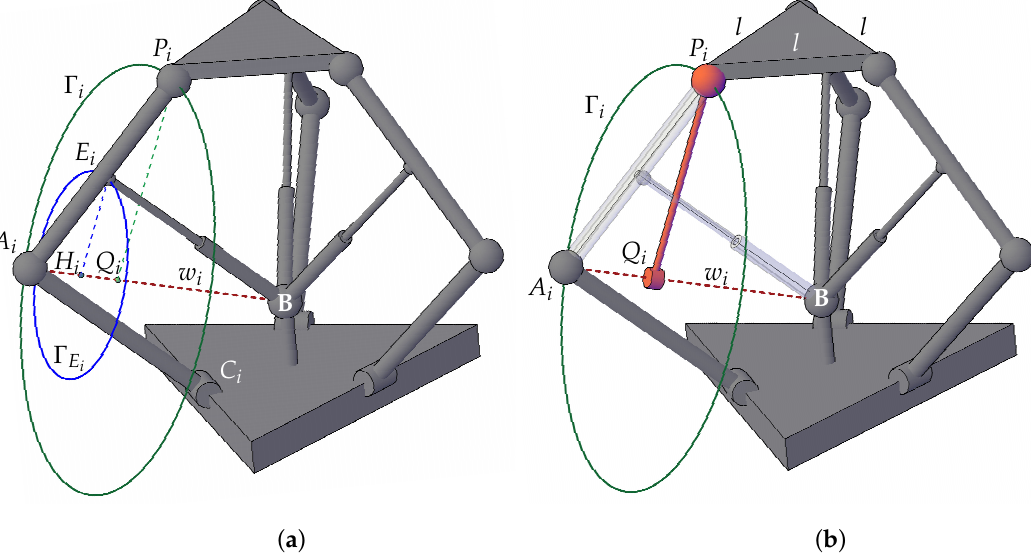
Figure 3. ( a ) The circles Γ E and Γ i as loci of points E i and P i , respectively, for the i th leg; ( b ) the virtual bar i Q i P i rotating along the axis w i parallel to the line A i B